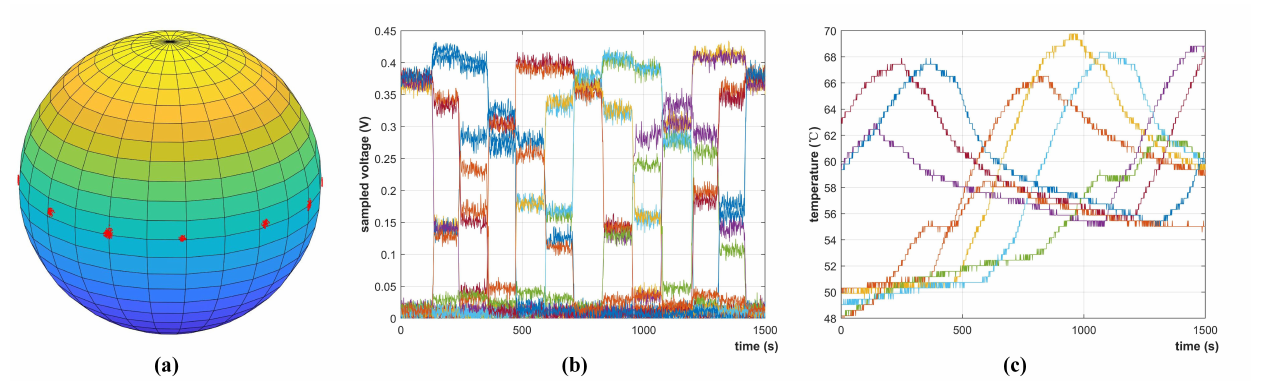
Figure 16. Raw measurements of IPSS and the inversed sun vector in satellite body frame during the ground experiment. ( a ) the inversed artificial sun vector in the satellite body frame. ( b ) sampled voltage curves of solar cells in the upper hemisphere. ( c ) sampled temperature curves of solar cells in the upper hemisphere.